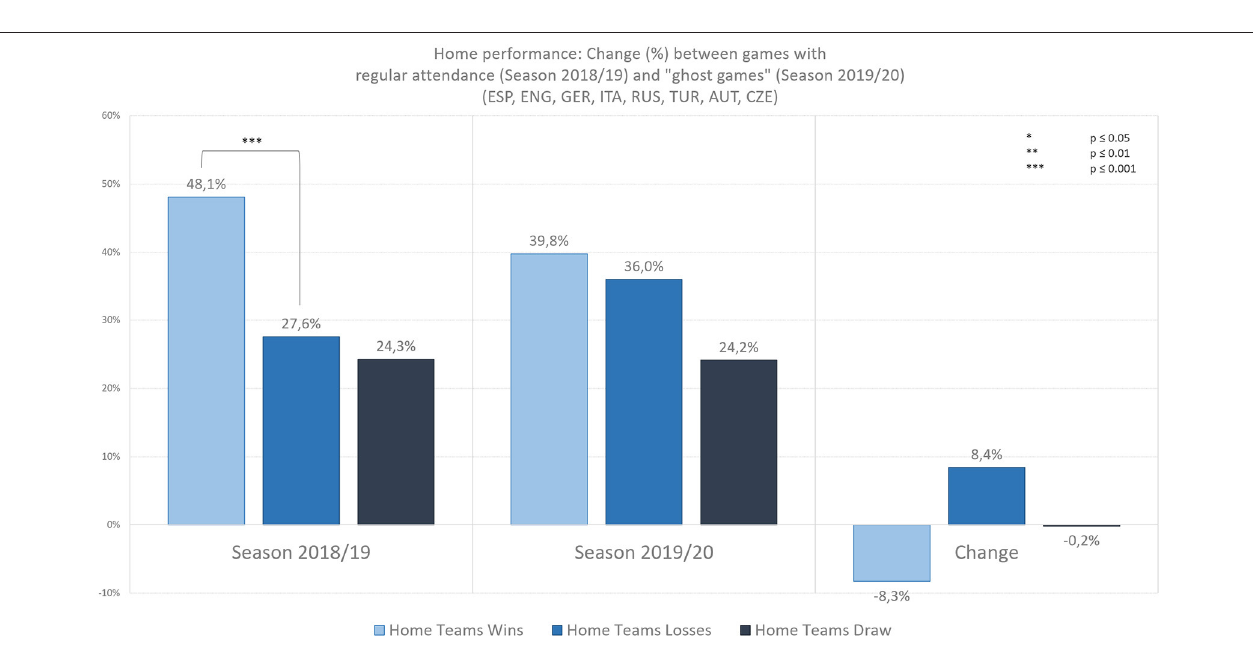
differences in match statistics. Following recent methodological developments in the research on the home advantage effect, four different methods were used for the assessment of the home